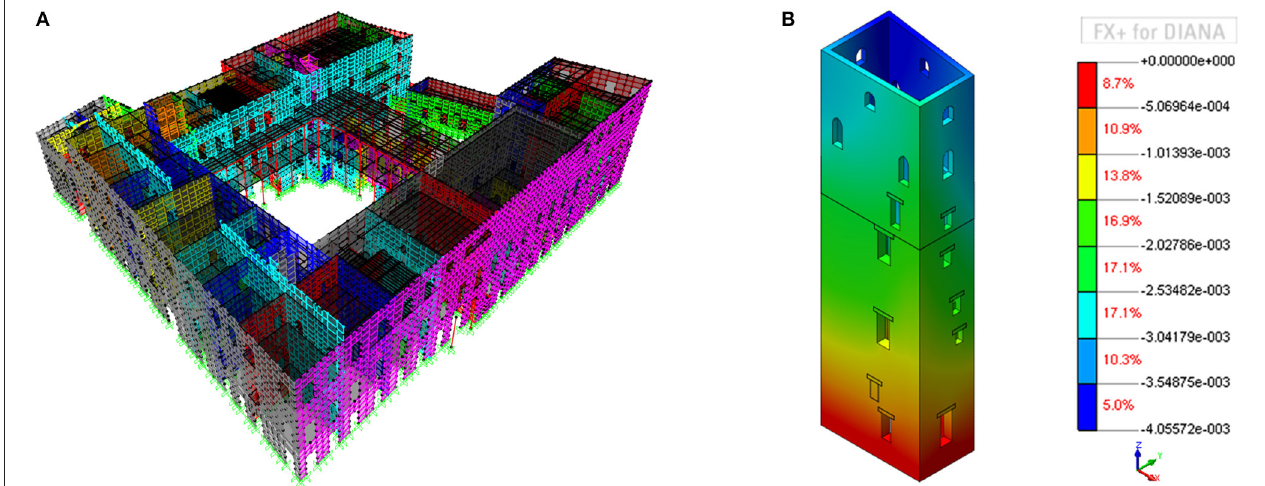
FIGURE 15 | Examples of 3D numerical models realized based on the information collected in the knowledge phase. (A) Palazzo Ducale; (B) Torre